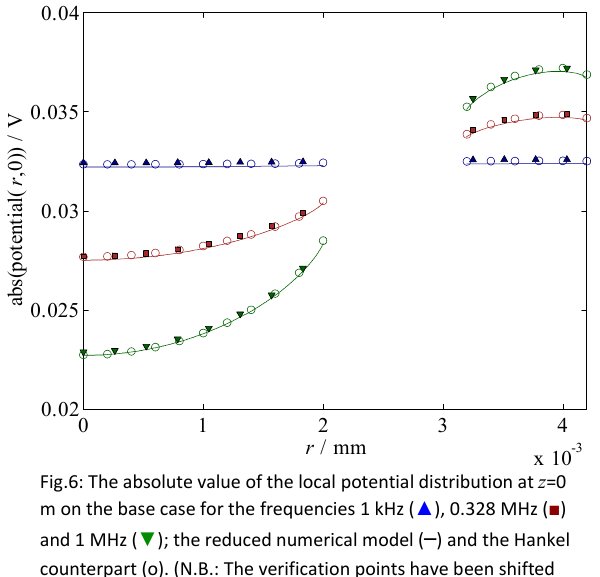
Fig.6: The absolute value of the local potential distribution at z =0 m on the base case for the frequencies 1 kHz ( ▲ ), 0.328 MHz ( ■ ) and 1 MHz ( ▼ ); the reduced numerical model ( – ) and the Hankel counterpart (o). (N.B.: The verification points have been shifted slightly along r to prevent overlap.)